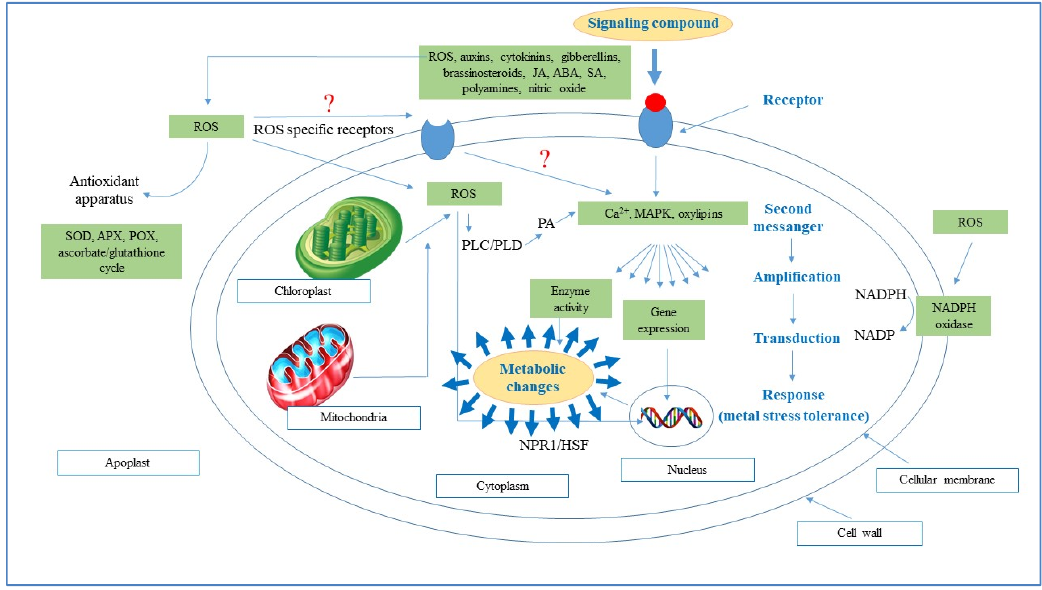
Figure 1. Schematization of signal transmission and transduction in plant cells. Abbreviation: ABA, abscisic acid; APX, ascorbate peroxidase; HSF, redox-sensitive transcription factor; JA, jasmonic acid; MAPK, mitogen-activated protein kinase; NADP, oxidized nicotinamide adenine dinucleotide; NADPH, reduced nicotinamide adenine dinucleotide; NPR1, redox-sensitive transcription factor; OXI1, serine / threonine kinase; PA, phosphatidic acid; PLC / PLD, phospholipases class C and D; POX, peroxidase; ROS, reactive oxygen species; SA, salicylic acid; SOD, superoxide